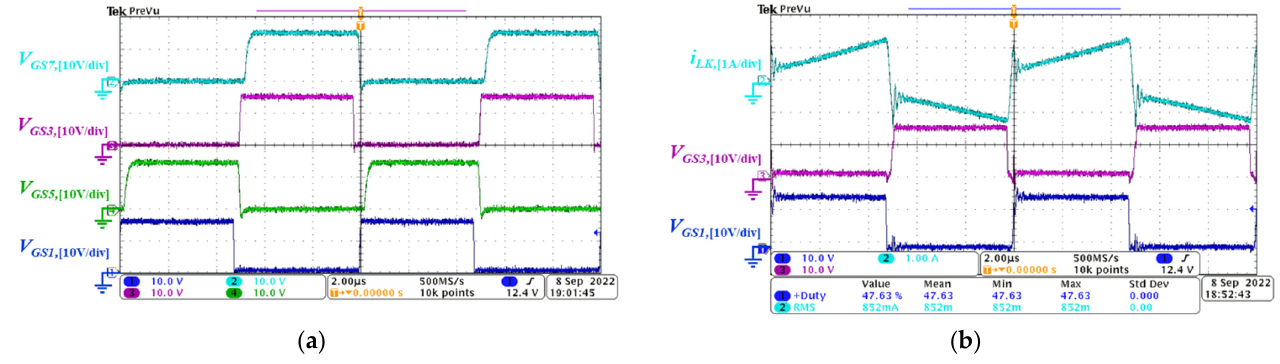
Figure 14. Experimental waveforms of the prototype converter operating in forward power conver- sion mode (at 300 W output power): ( a ) waveforms of gate signals V GS1 , V GS3 , V GS5 and V GS7 ; ( b ) wave- forms of gate signals V GS1 , V GS3 and inductor current i LK .